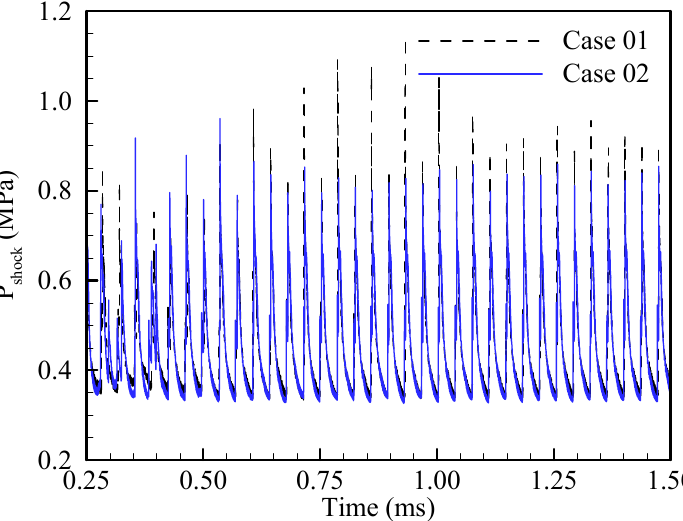
Figure 2. Grid refinement study using post shock pressure (number of grid points within the induction zone; Case 01–15 grid points, Case 02–30 grid points).